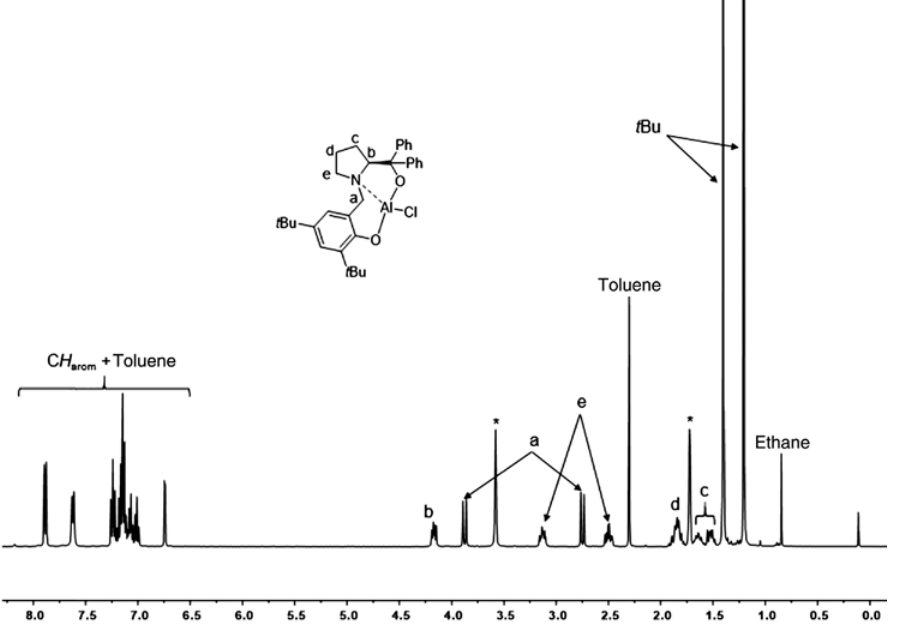
, 500.1 MHz, 298 K) of ( S )-{OˆO}AlCl ( 1 ) generated in situ upon reaction of ( S )-{OˆO}H 8